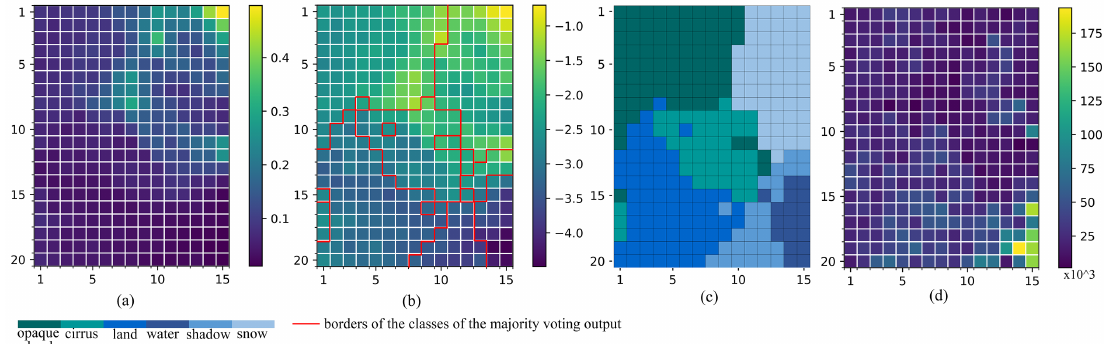
Figure 5. ( a ) U-matrix, ( b ) U-matrix with logarithmic scale, ( c ) majority voting output ( d ) hit rate